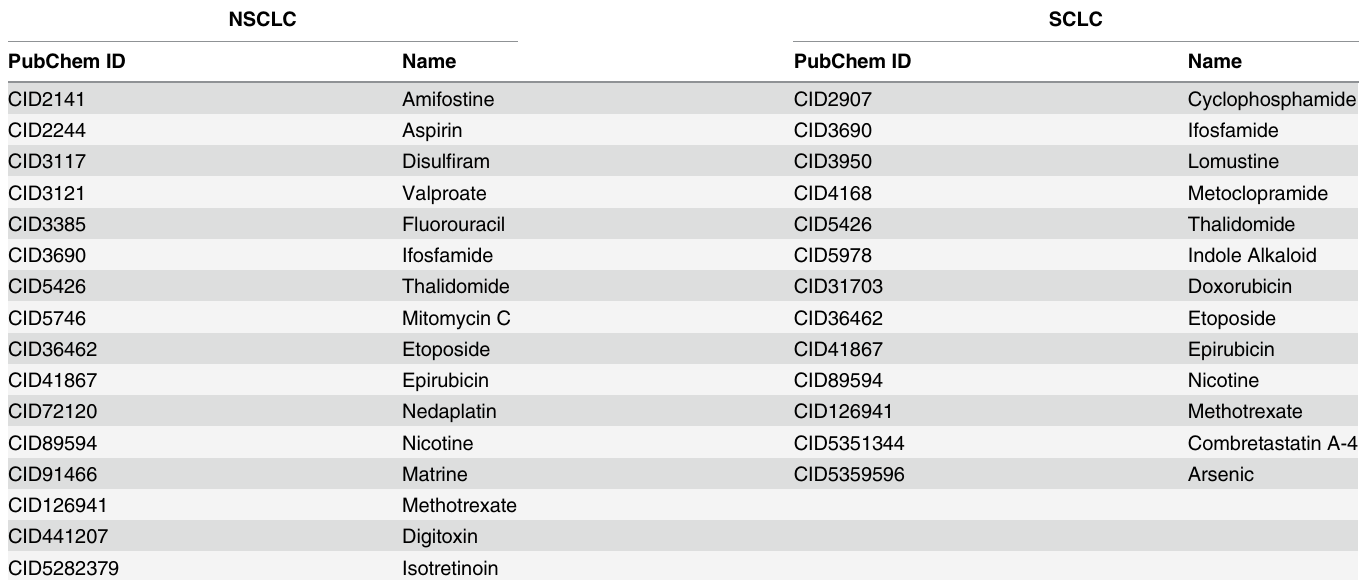
Table 1. Chemicals related to two types of lung